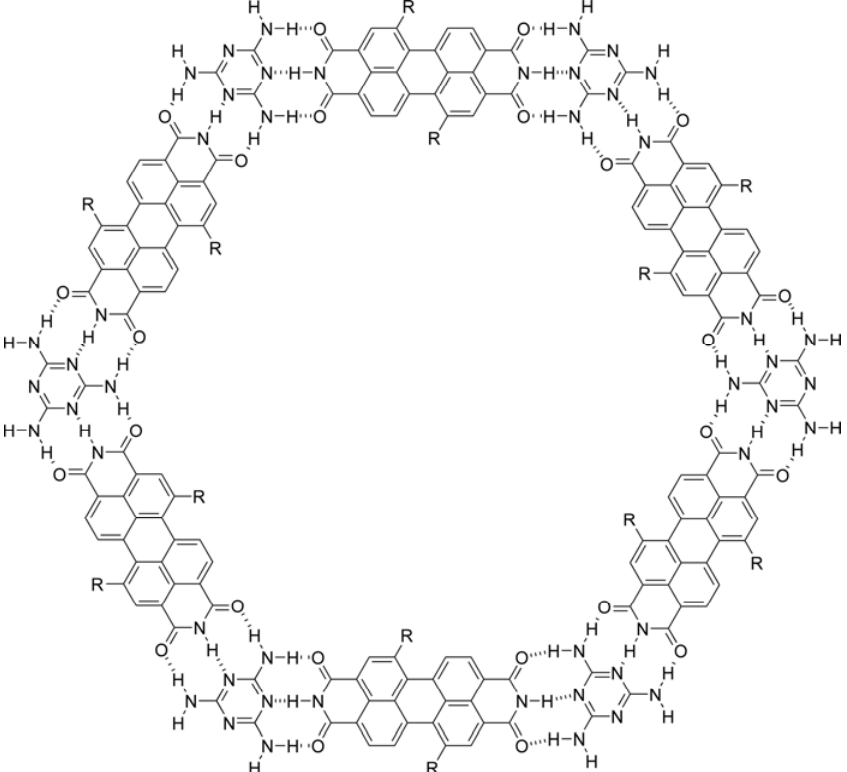
Figure 9. Self-assembled bimolecular